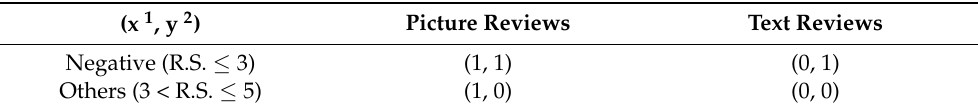
Table 8. Type of review—Review score 1.